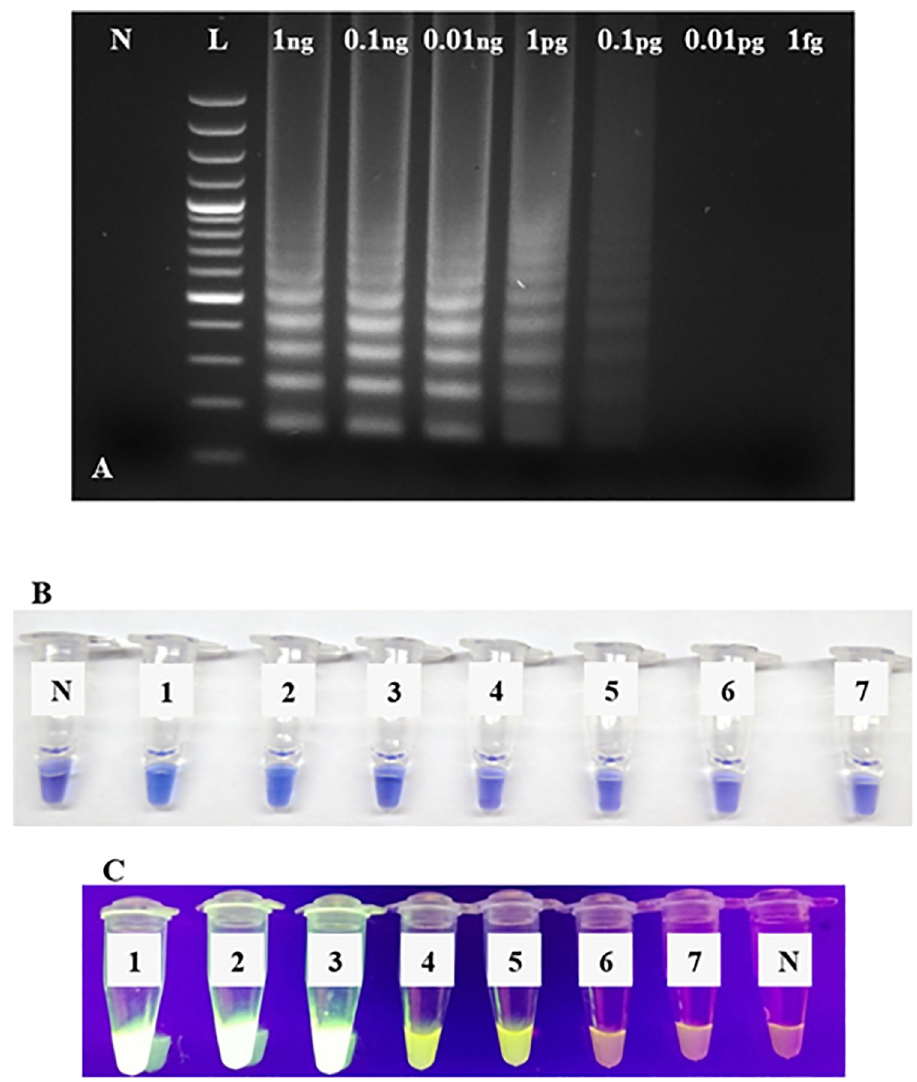
Fig 5. RRV-P3 RT-LAMP Limit of Detection (LoD) assays using Bst 2.0 DNA polymerase. (A) RT-LAMP LoD by gel electrophoresis using a ten-fold serially diluted RRVP-3 plasmid starting from 1ng/ μ L to 1fg/ μ L. Lane N, is a non- template control (NTC, water); lane L, is a 100 bp DNA ladder. (B) RT-LAMP colorimetric LoD using HNB and ten- fold serially diluted RRV-P3 plasmid starting from 1ng to 1fg. Tube N, is a non-template control (NTC, water); tube 1, 1ng/ μ L; tube 2, 0.1ng/ μ L; tube 3, 0.01ng/ μ L; tube 4, 1pg/ μ L; tube 5, 0.1pg/ μ L; tube 6, 0.01pg/ μ L; tube 7, 1fg/ μ L. (C) RT-LAMP colorimetric LoD using SYBR Green I and ten-fold serially diluted RRV-P3 plasmid starting from 1ng to 1fg. Tube 1, 1ng/ μ L; tube 2, 0.1ng/ μ L; tube 3, 0.01ng/ μ L; tube 4, 1pg/ μ L; tube 5, 0.1pg/ μ L; tube 6, 0.01pg/ μ L; tube 7, 1fg/ μ L. Tube N, is a non-template control (NTC,